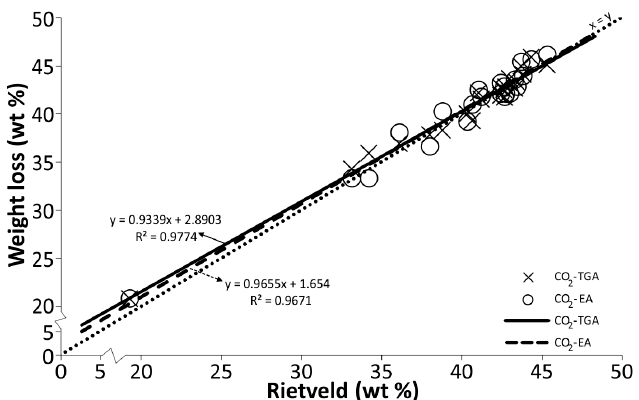
Figure 5. Conciliation of the CO 2 content derived from mineral quantification by the Rietveld method (XRD) against CO 2 mass loss by thermogravimetry (TGA) represented by X and with elemental carbon (presented as CO 2 ) as measured by elemental analysis (EA) represented by circles (wt %). Data in Table S4.